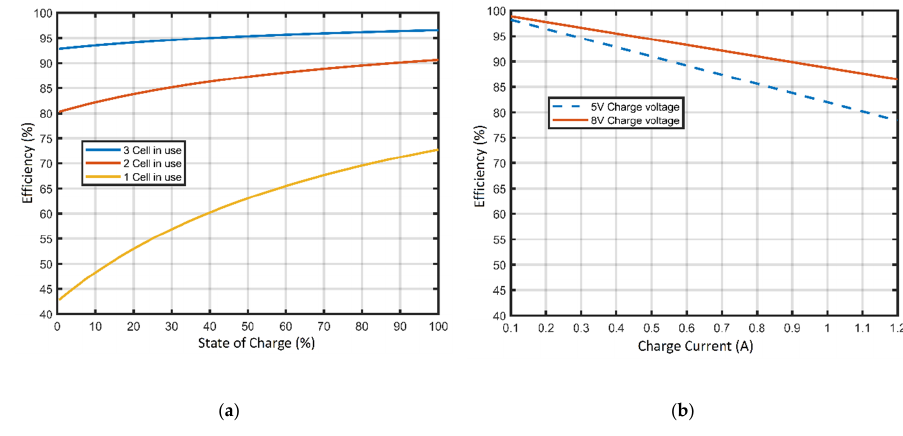
Figure 13. ( a ) Discharge efficiency; ( b ) Charge efficiency.